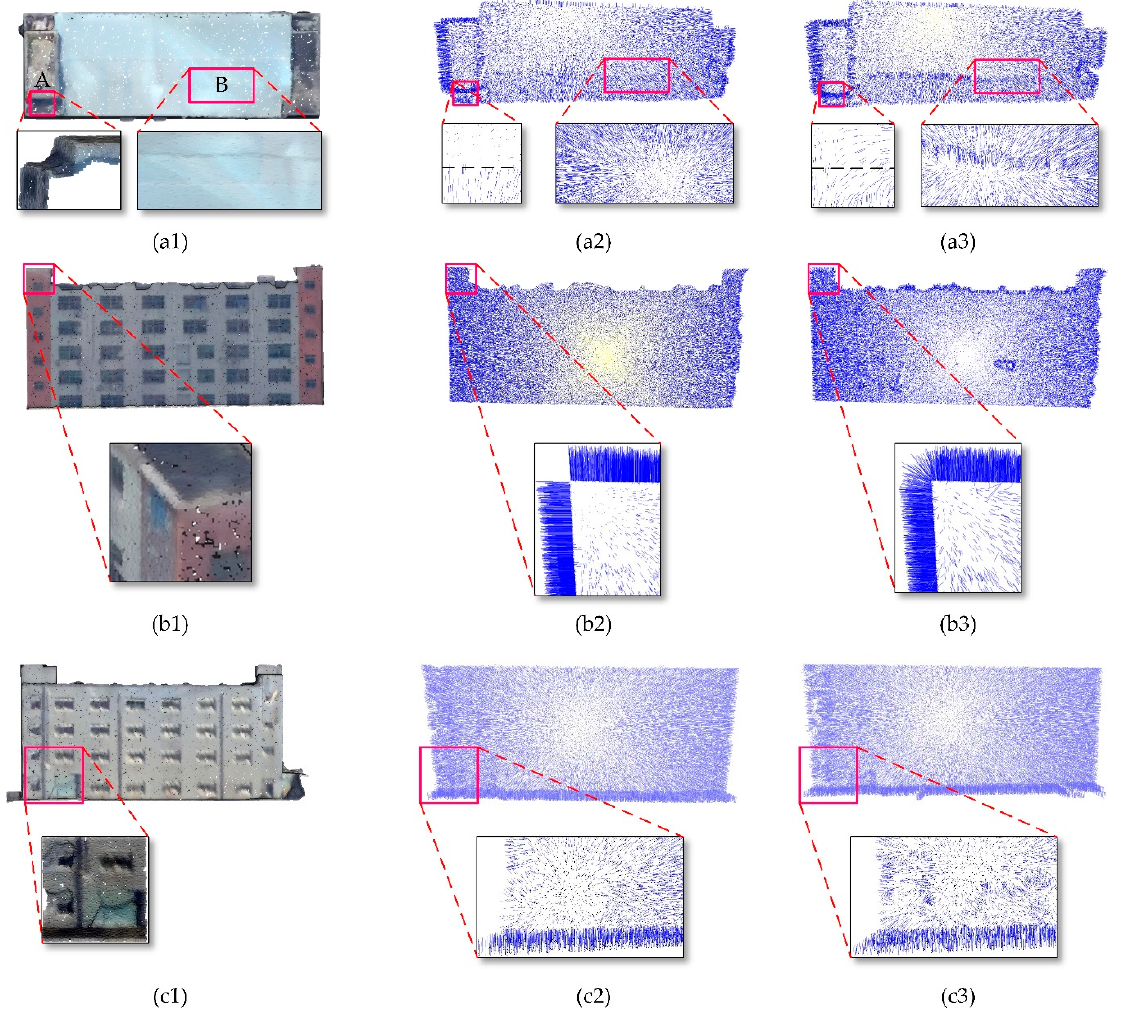
Figure 7. Normal vectors visualization. The left column represents photogrammetric point clouds, the middle column represents normal vectors optimized by IPA, and the right column represents initial normal vectors estimated by the PCA.